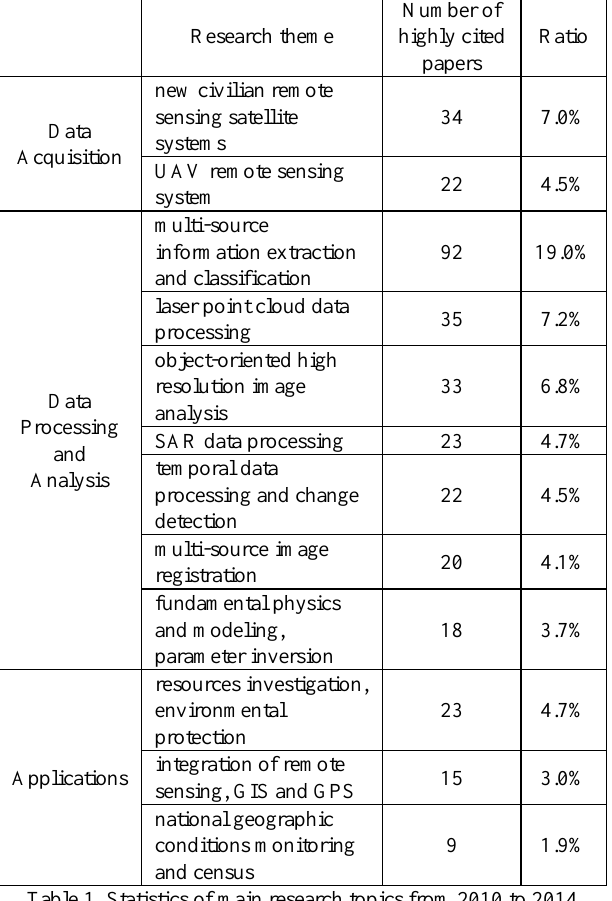
Table 1. Statistics of main research topics from 2010 to